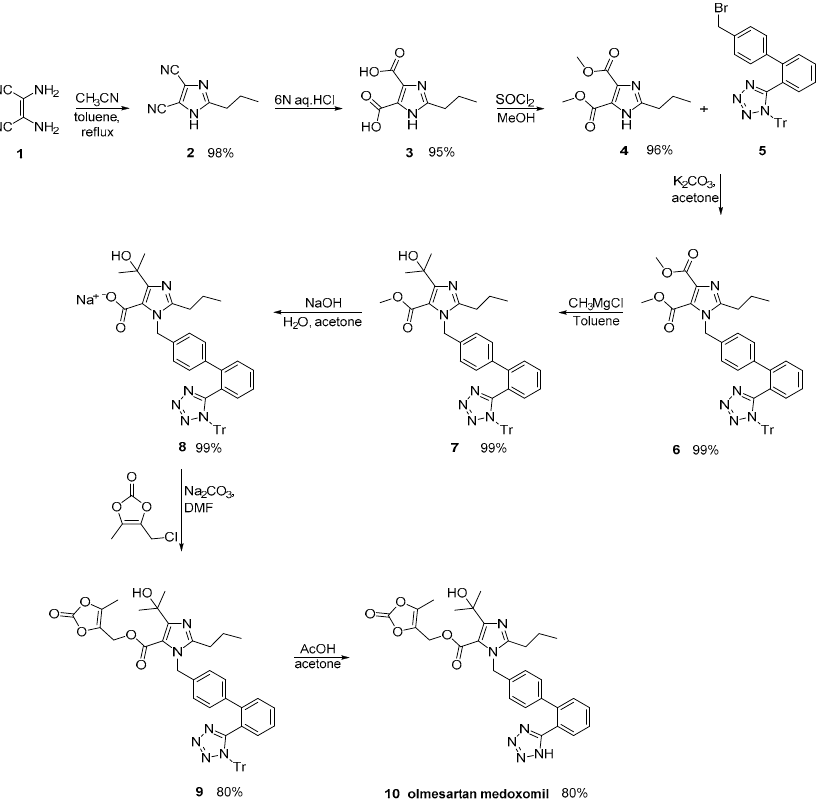
Scheme 22. Synthesis of the prodrug olmesartan medoxomil by Babu et al. [51]. Venkanna et al. identified the impurities resulting from the olmesartan medoxomil synthetic process (Scheme 23, [52]).